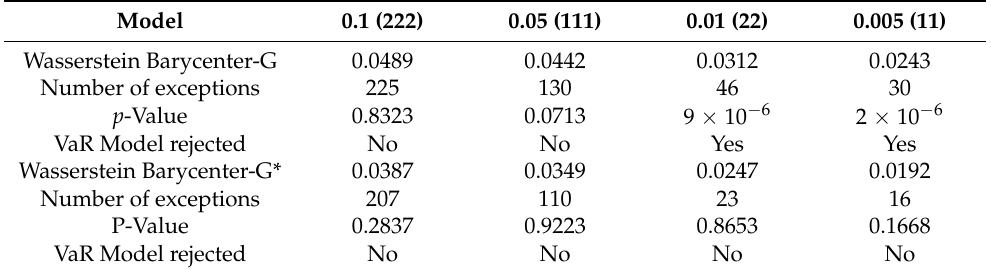
Table 2. Wasserstein Barycenter VaR, for t = 751 to 2971; number of exceptions where the estimated VaR was exceeded by the portfolio loss with α = 0.1,0.05,0.01,0.005. p -values of tests are